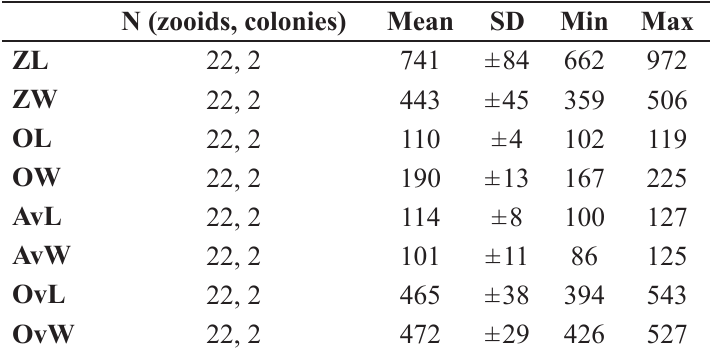
Table 4. Measurements in µm of Microporella hyadesi (Jullien, 1888), Recent, Discovery